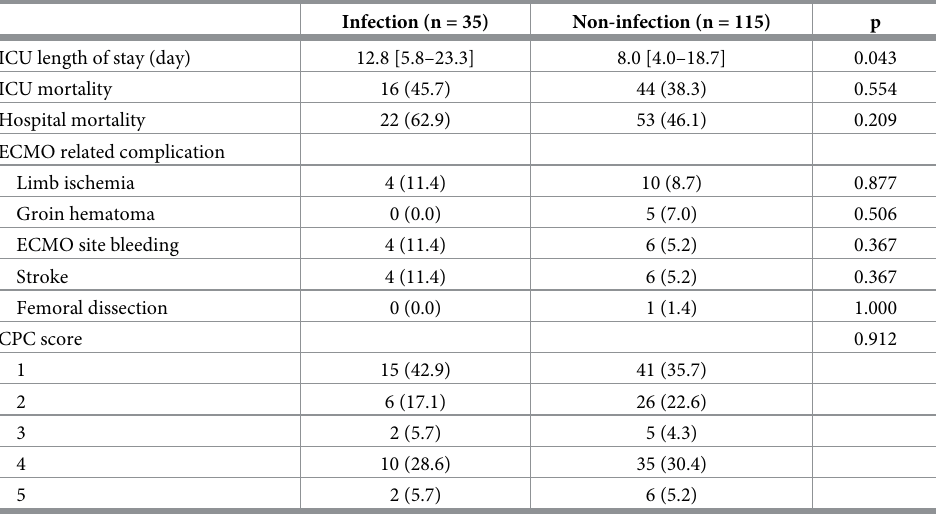
Table 2. Clinical outcomes according to the presence of nosocomial